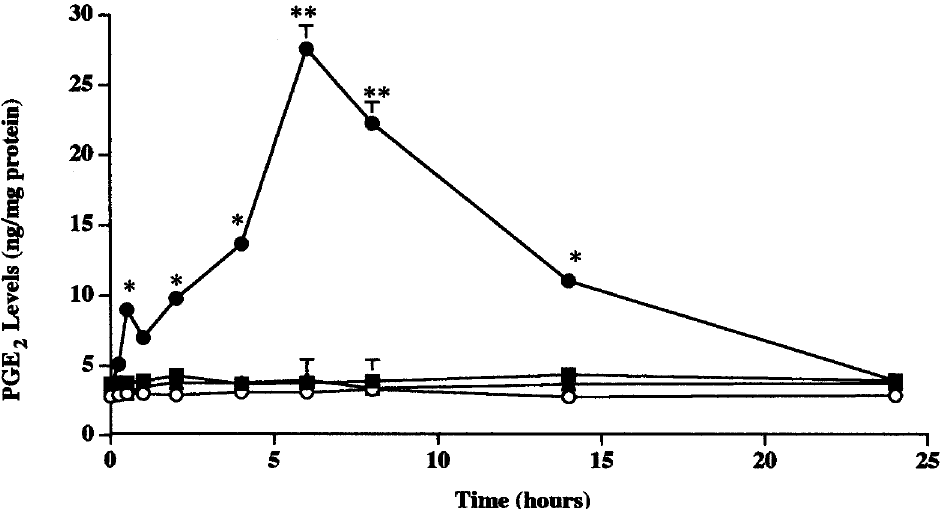
FIG. 7. Levels of PGE 2 in ( d ) cells treated with IL-1 b (10ng/ml) as compared with ( j ) control untreated cells, with ( s ) cells treated with the IL-1ra and with ( m ) cells treated with IL-1 b and IL-1ra together. * P <0.05, ** P <0.005; P value represents the comparison of the treatment on PGE 2 production as compared with untreated time control. Data are means±SE for six separate